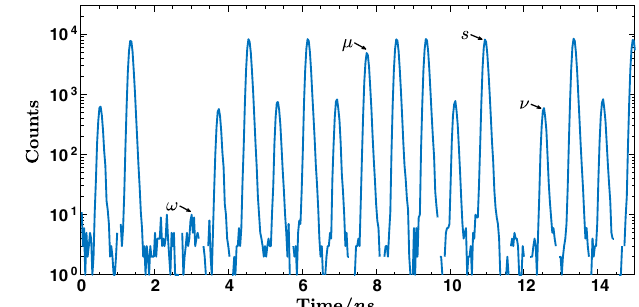
FIG. 8. Histogram measurement of different intensities using the chip. Four varying intensities can be used for signal ( s ) and three decoy states ( μ , ν , ω ).